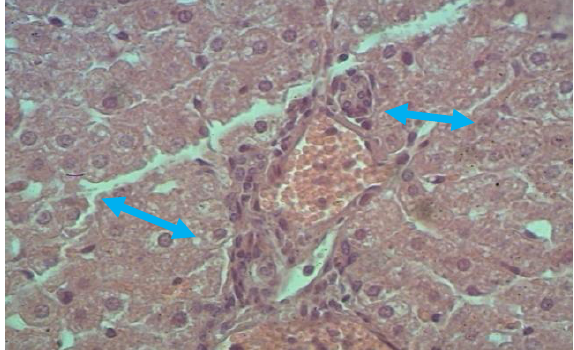
Figure, 2: Histopathological section in liver of sheep infected by Toxoplasma gondii shows inflammatory cells aggregation around the blood vessels forming as a nest ( ) with congestion of B.V ( ). (H and EX400).